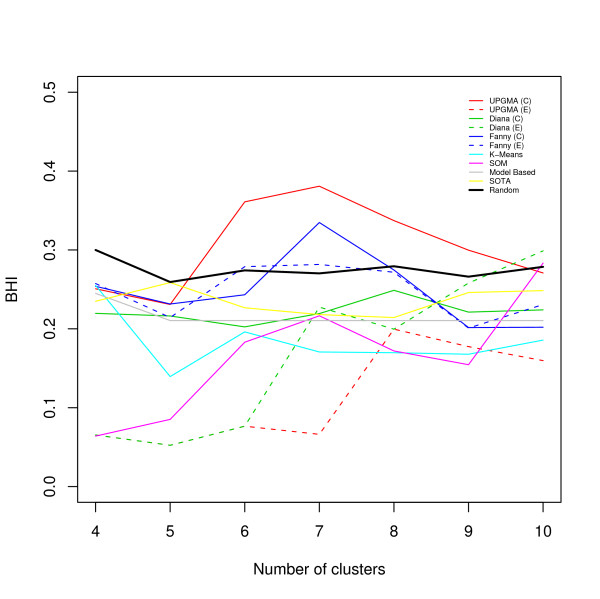
BHI for various clustering algorithms applied to the normal and DCIS samples in breast cancer data. The thick black line is the 95th percentile of BHI values under random clustering.